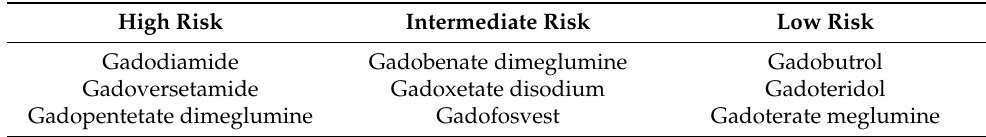
Table 2. EMA classification for NSF risk among GBCAs § .